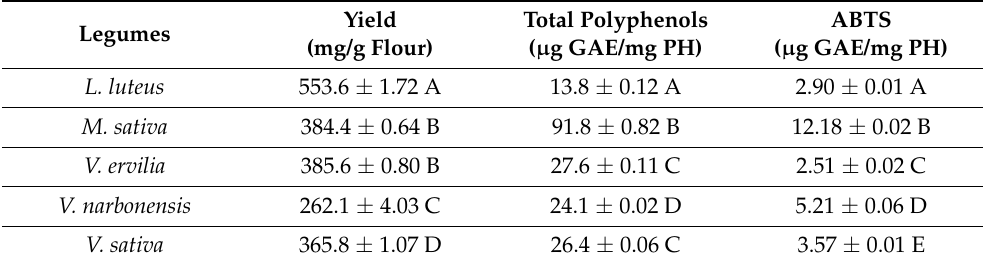
Table 3. Quantification of the total polyphenols and antioxidant capacity in different legume species (only raw flour).